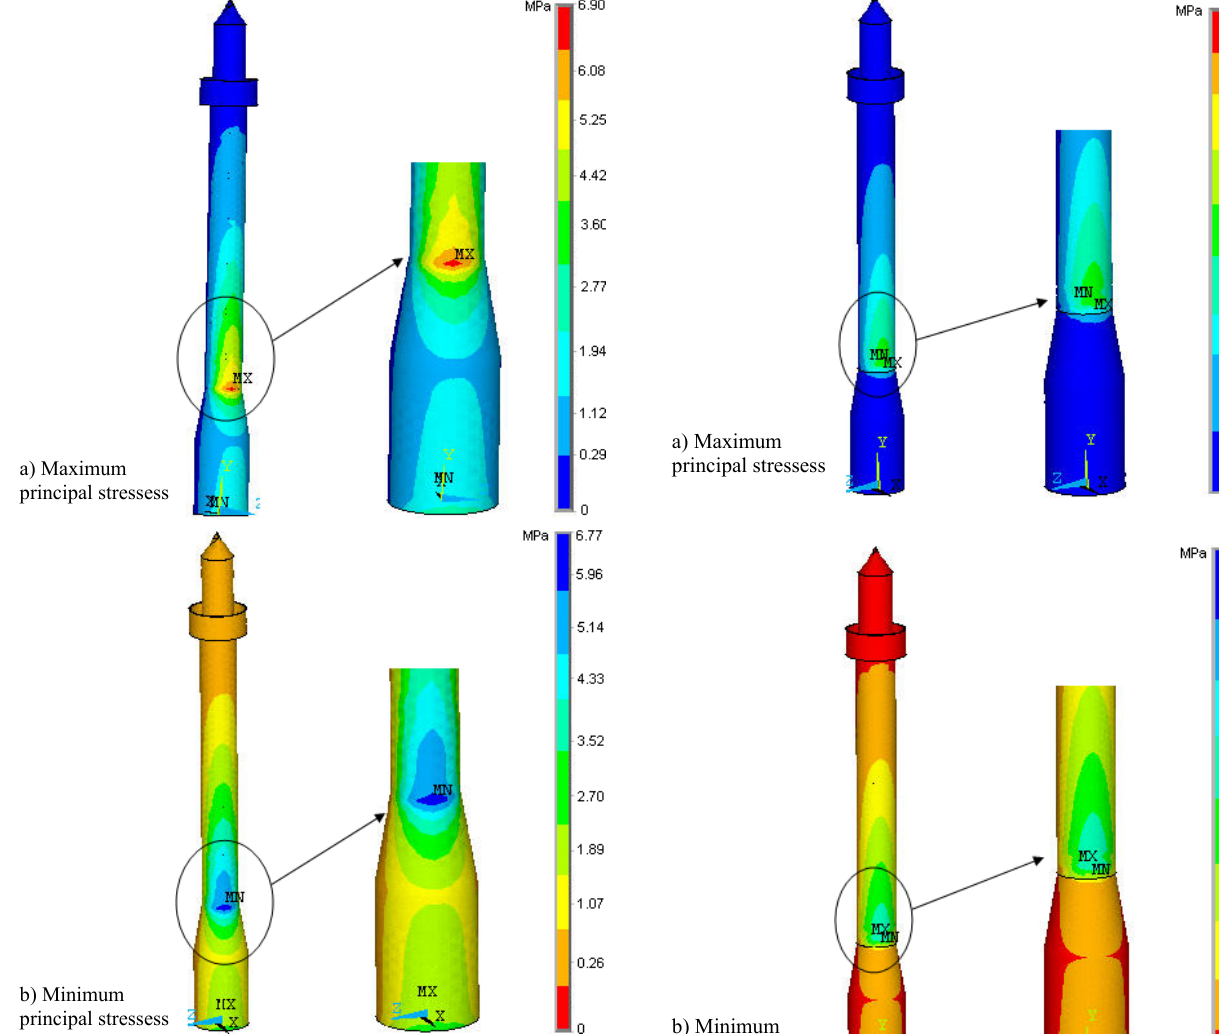
Figure 12 Maximum and minimum principal stress contours of İ skenderpa ş a historical minaret obtained before FRP composite strengthened Figure 13 Maximum and minimum principal stress contours of İ skenderpa ş a historical Fig. 12. Maximum and minimum principal stress contours of minaret obtained after FRP composite strengthened the ˙Iskenderpas¸a historical minaret obtained before FRP compos- Fig. 13. Maximum and minimum principal stress contours of ite strengthening the ˙Iskenderpas¸a historical minaret obtained after FRP composite strengthening